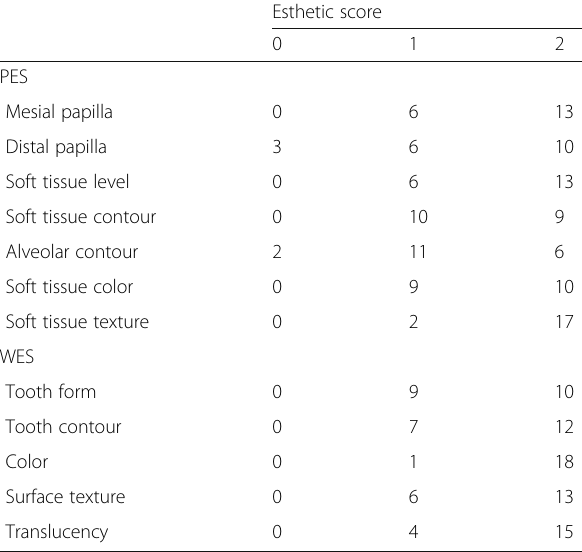
Visual analogue scale and subjective outcome